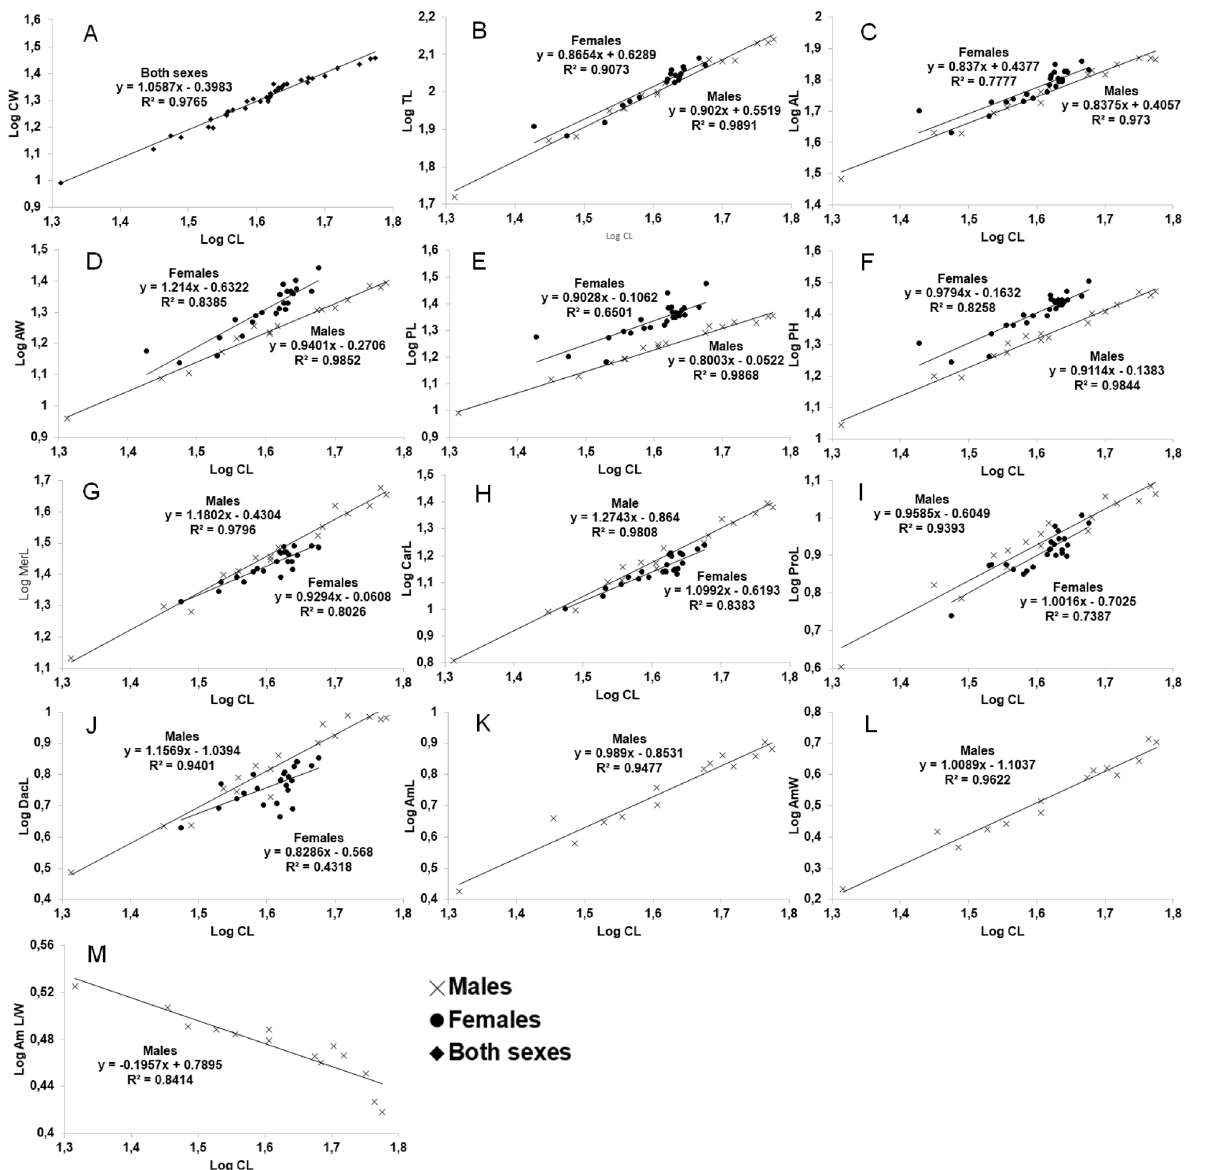
Figure 4. Comparison between morphometric relationships of males and females of Atya gabonensis Giebel, 1875 at the Fluvial Island Domain in the Paraíba do Sul River basin. (CL) carapace length as independent variable and the dependent variables: A , (CW) carapace width; B , (TL) total length; C , (AL) abdomen length; D , (AW) abdomen width; E , (PL) length of the second abdominal pleuron; F , (PH) height of the second abdominal pleuron; G , (MerL) merus length; H , (CarL) carpus length; I , (ProL) propodus length; J , (DacL) dactylus length; K , (AmL) length of male appendix interna; L , (AmW) width of male appendix interna; M , (Am L/W) male appendix interna